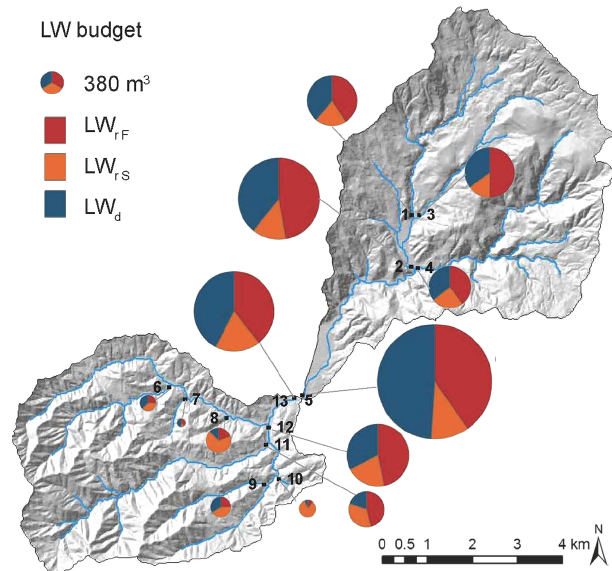
Figure 6. LW budget summarized at the sub basin scale (LW r F = LW recruitment from floodplain, LW r S = recruitment from hillslopes, LW d = LW deposited) in the different sub- catchments of the Gravegnola and Pogliaschina basins. The size of the circles depends on LW recruited in each sub-catchment (i.e. the input of the budget). 1 Casserola, 2 Casserola, 3 Suvero, 4 Veppo, 5 main Gravegnola, 6 Pogliasca, 7 Redovego, 8 Sottano, 9 Ginepro, 10 Benoia, 11 Redarena, 12 Cassana, 13 main